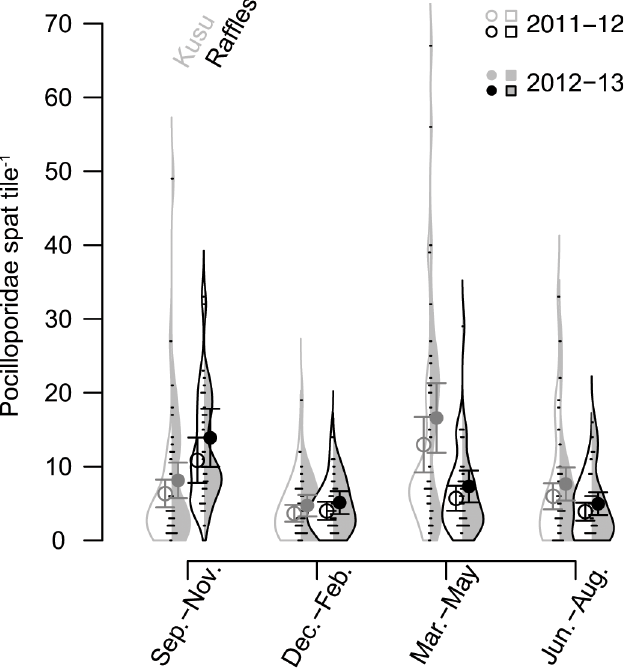
Fig 3. Beanplot of Pocilloporidae settlement at Kusu (grey outlines and points) and Raffles Lighthouse (black outlines and points). Shape of vertical distribution represents relative smoothed density distribution of counts. White fill on left side of beans represents 2011 – 12, and grey fill on the right side of beans represents 2012 – 13. Points are predictions from final model ± 95% CI.